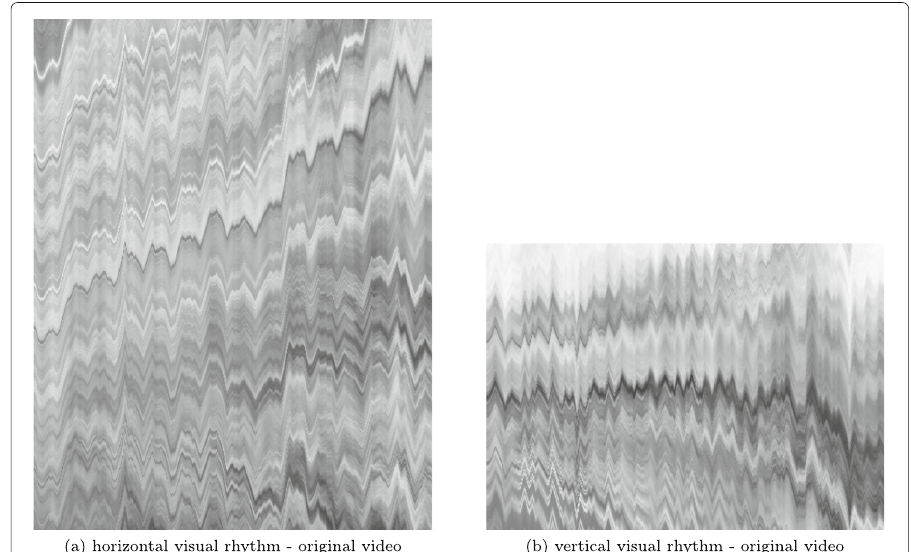
Fig. 12 Visual rhythms for original video #1 . a Horizontal visual rhythm. b Vertical visual rhythm